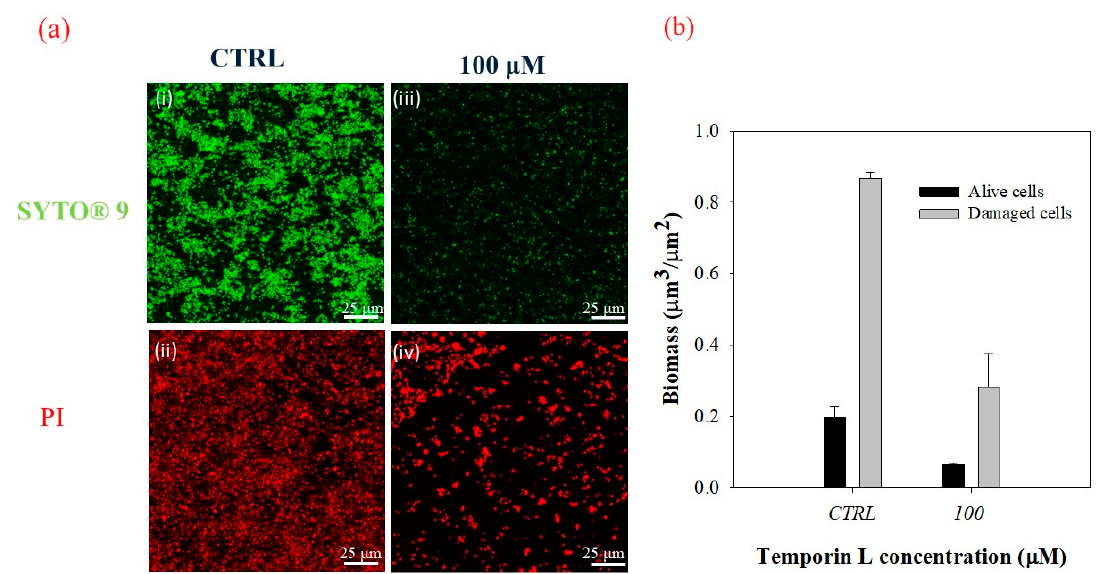
Figure 4. ( a ) CLSM images of 3 days-old biofilms cultivated under in flow conditions under the action of TL (100 μ M). CTRL (i, ii), 100 μ M TL (iii,iv). Experiments were carried out by dissolving TL in the bacterial suspension at the inoculation. Biofilms were double-stained with the LIVE/DEAD BacLight Bacterial Viability Kit. Alive cells were stained with the green fluorescent dye, SYTO ® 9 (3 μ L/mL). Damaged cells were stained with Propidium Iodide (1 μ L/mL). The staining procedure was performed at the same time; 63X magnification, scale bar = 25 μ m. ( b ) Biomass ( μ m 3 / μ m 2 ) of alive and damaged cells in the function of the TL concentration. The alive and dead cells ratio was measured as 0.23 in the control, and 0.22 in the TL treated sample—confirming the antibiofilm activity of the peptide.